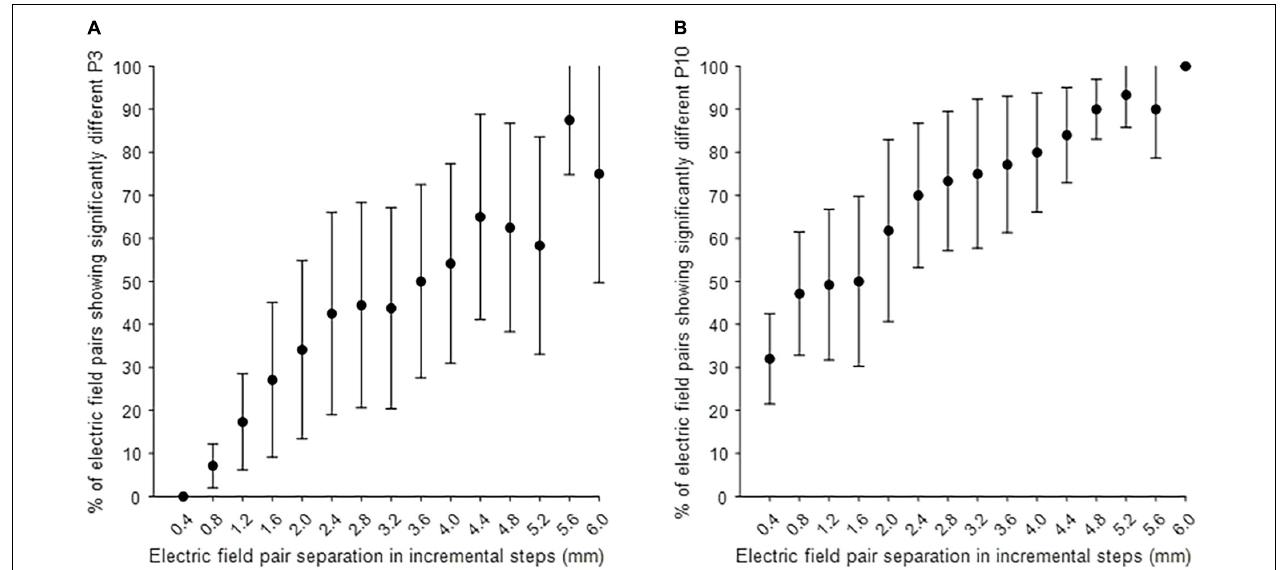
FIGURE 3 | Post hoc analysis on the separability of electric field pairs on P3 and P10 amplitude. (A) The separability of MICC-controlled electric field depth on P3 amplitude in all tested hemispheres ( n = 4). (B) The separability of MICC-controlled electric field depth on P10 amplitude in all tested hemispheres ( n = 5). The x-axis shows the separation of electric field pairs in incremental steps (mm), varying from one step to fifteen steps with a proportional distance of 0.4 mm and the y-axis shows the percentage of electric field pairs showing a significantly different P3 or P10 peak amplitude (mean ± CI) in all tested hemispheres after Bonferroni correction was applied.